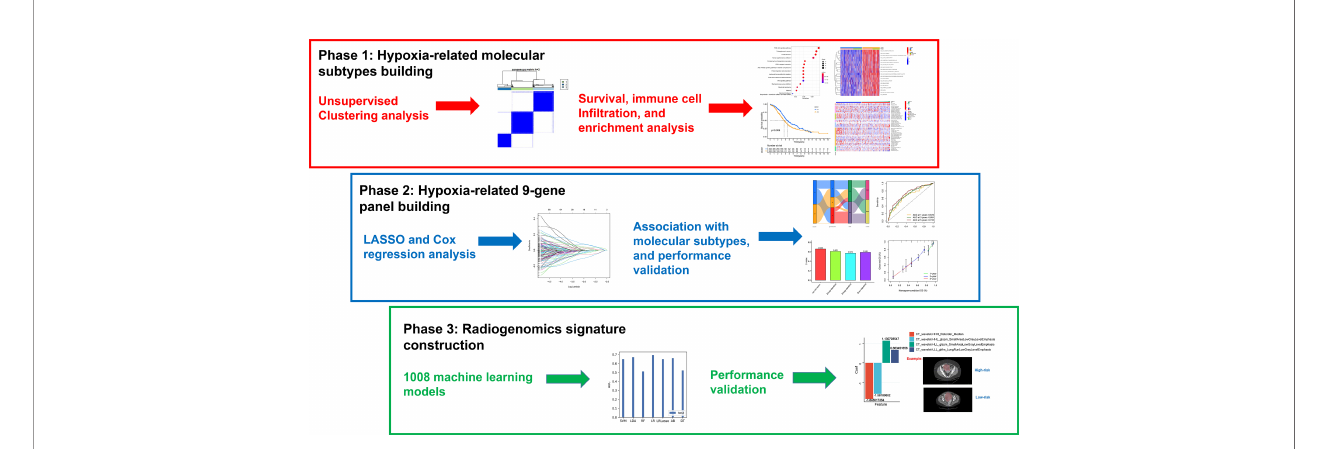
FIGURE 1 | The work fl ow of